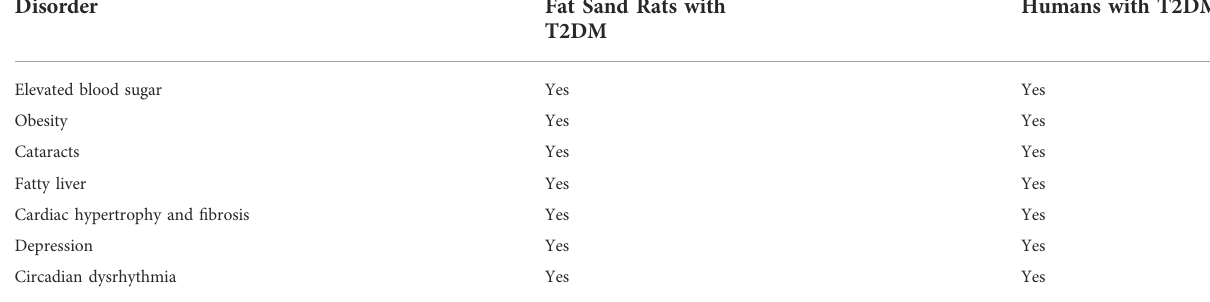
TABLE 1 Common disease manifestations of T2DM in fat sand rats and in humans.